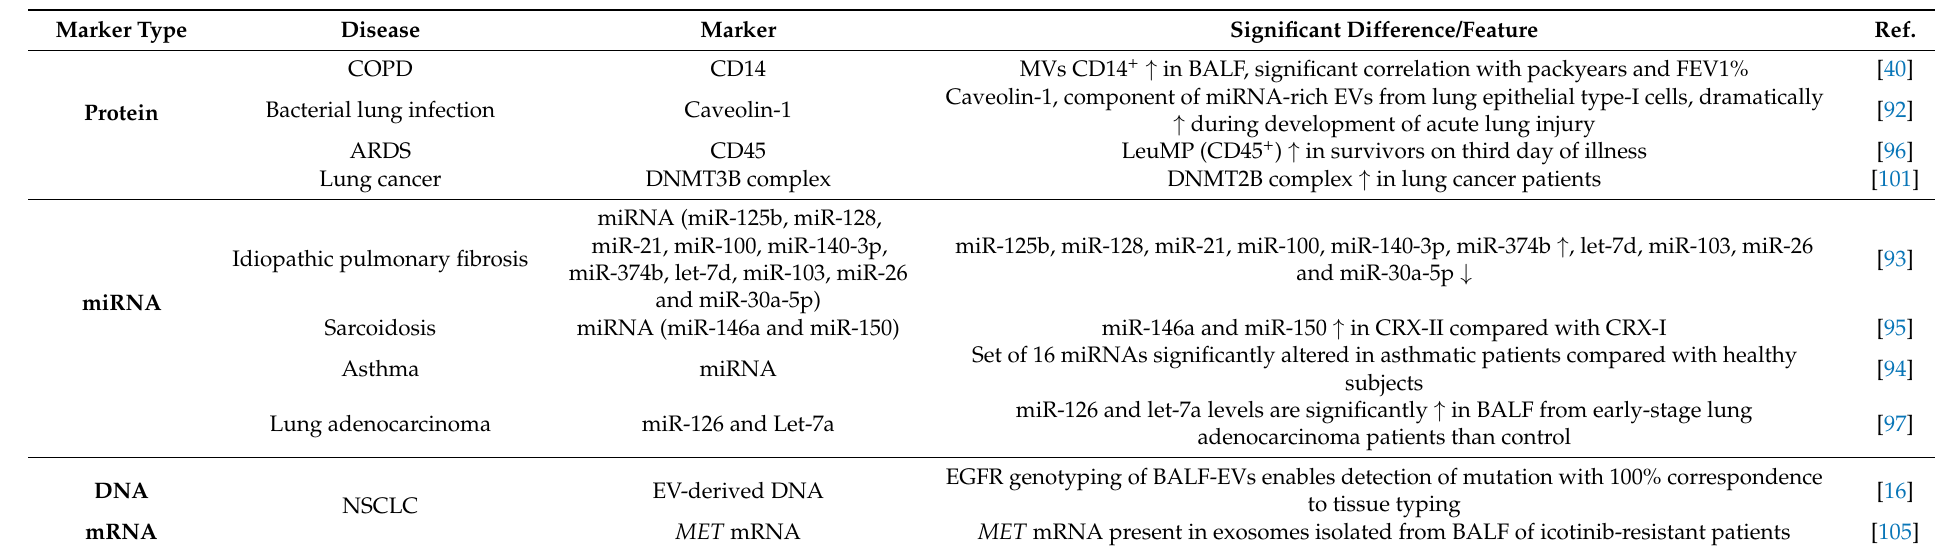
Table 3. BALF-EVs as biomarkers of different lung